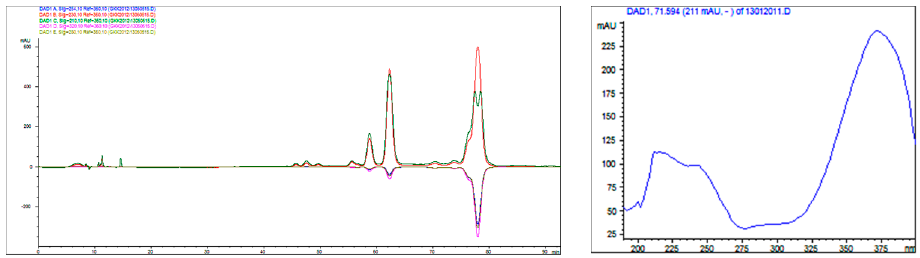
Figure 4. The HPLC and UV chromatograms of 2-aminoimidazole alkaloids. Compound 1 : 4-{[5-(3,4-dimethoxybenzyl)-4-(4-methoxybenzyl)-1-methyl-1 H -imidazol-2-yl]